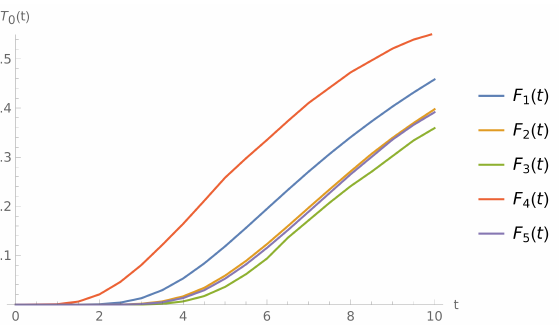
Figure 5. The CDFs T 0 ( t ) for µ = 21, µ v = 12, 1/ α = 9, and different types of input stream. Example 6. The arrival intensity is λ ≈ 15 . The server works with intensity µ v = 9 in WV mode, and the mean time spent in WV is 1/ α =